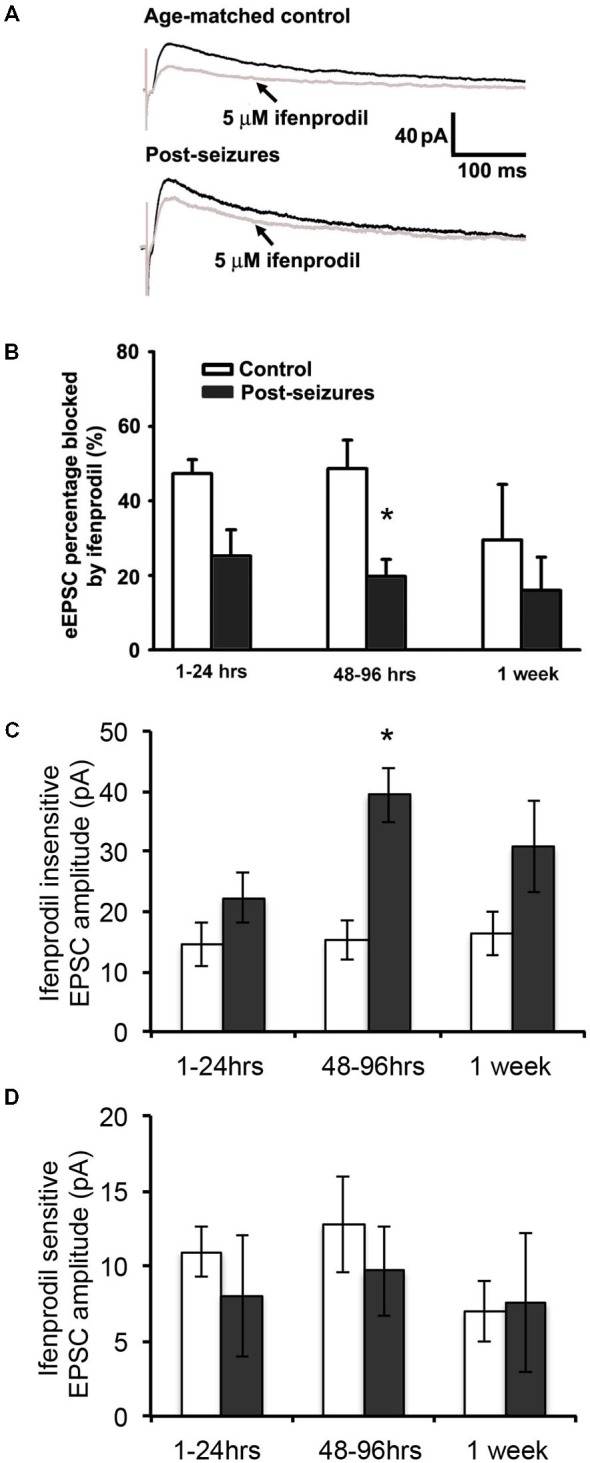
Hypoxic seizure-induced increases in GluN2A-containing GluN eEPSCs. (A) Representative GluN eEPSC traces before (black) and after bath application of 5 μM ifenprodil (gray) in hippocampus CA1 pyranmidal neurons at +40 mV holding potential from control and 96 h post-HS rats. (B) Group data of ifenprodil sensitivity in CA1 pyramidal neurons in slices from 1–24 h (n = 11 cells), 48–96 h (n = 11 cells) and 1 week post-HS rats (n = 5 cells) and slices from littermate controls (n = 6–10 cells). *p < 0.05. Error bars indicate S.E.M. (C) Group data of absolute GluN2A-containing GluN eEPSC amplitude (ifenprodil insensitive component) in CA1 pyramidal neurons in slices from 1–24 h (n = 11 cells), 48–96 h (n = 11 cells) and 1 week post-HS rats (n = 5 cells) and slices from littermate controls (n = 6–10 cells). *p < 0.05. Error bars indicate S.E.M. (D) Group data of absolute GluN2B-containing GluN eEPSC amplitude (ifenprodil sensitive component) in CA1 pyramidal neurons in slices from 1–24 h (n = 11 cells), 48–96 h (n = 11 cells) and 1 week post-HS rats (n = 5 cells) and slices from littermate controls (n = 6–10 cells). Error bars indicate S.E.M.